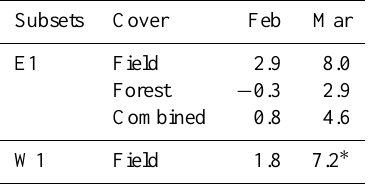
Table 1. Mean monthly values of A S averaged over the two subsets of Fig. 1 for field and forest cover. A negative sign indicates snow deposition (condensation); positive indicates